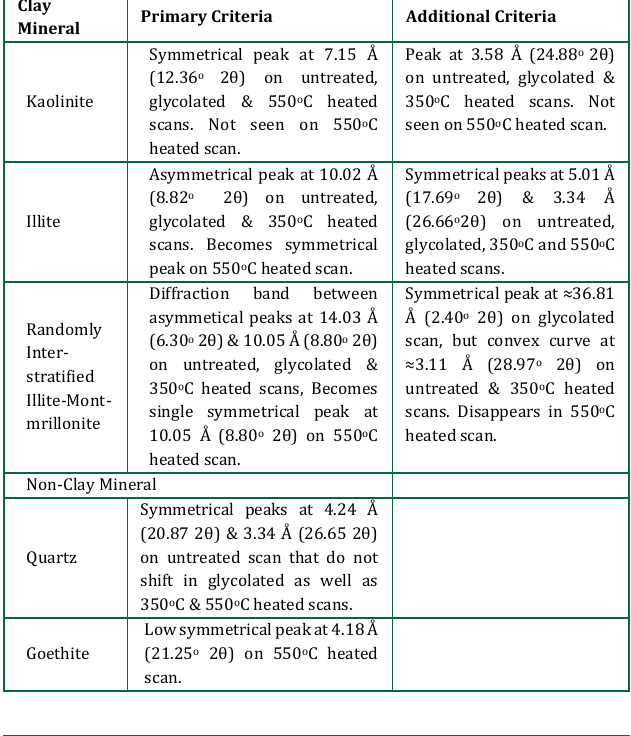
Table 9: Clay sized minerals in mudstones from different